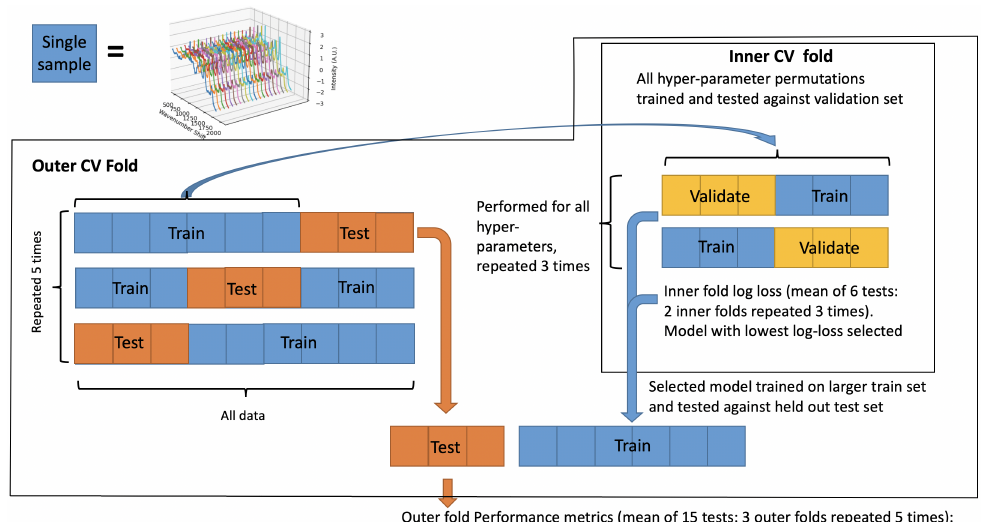
Figure 1. Nested CV